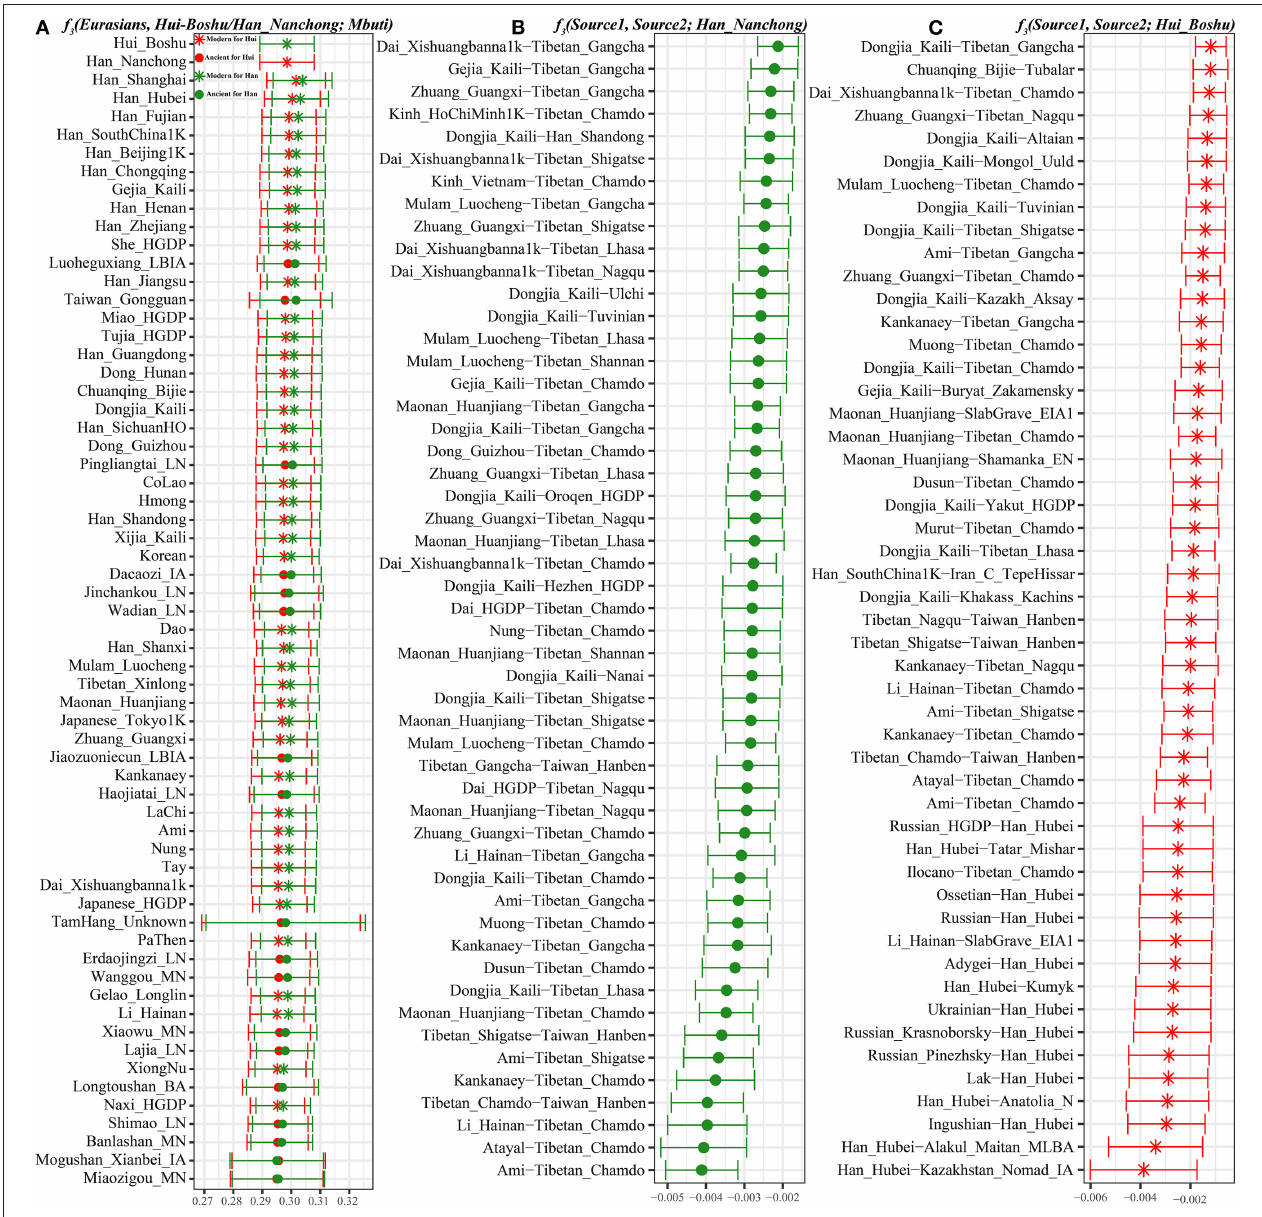
FIGURE 3 | The shared genetic drift and admixture signal for the targeted Han and Hui populations. (A) . The top 60 populations harboring genetic affinity with Boshu Hui (red color) and Nanchong Han (green color). (B,C) . Top sixty pairs of source populations possessing admixture signals via three-population testing in the form of f 3 (Source1, source2; Boshu Hui/Nanchong Han) . All showed population pairs with Z-scores less than negative three.